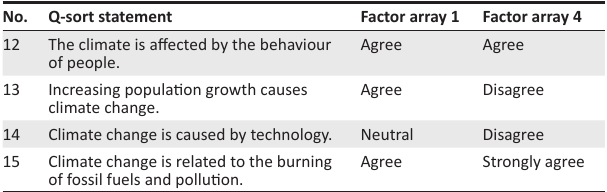
TABLE 5: Factor arrays of Q-sort statements related to climate change